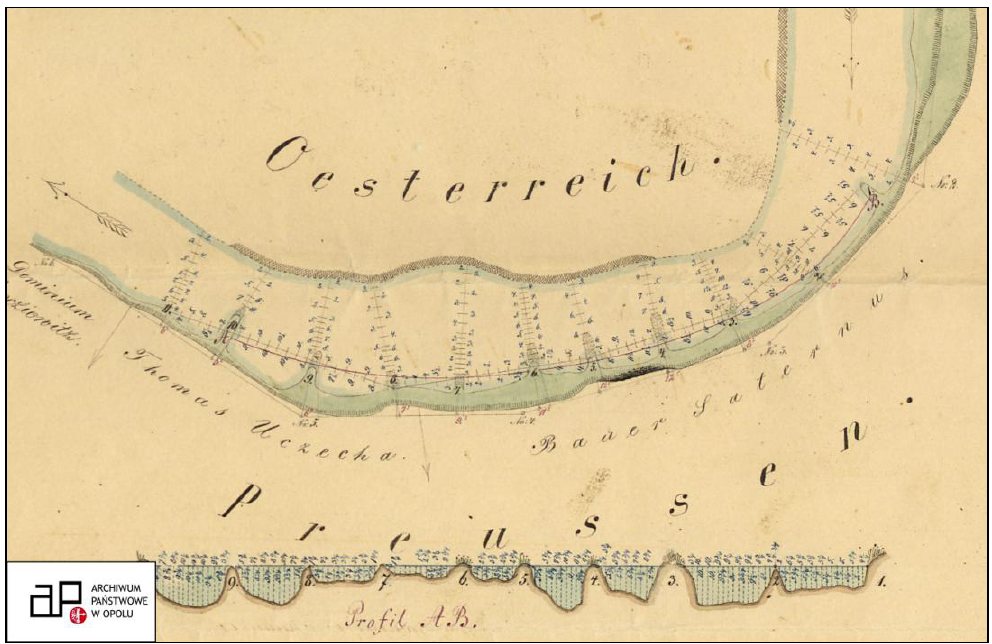
Fig. 3. Hydraulic structures in the River Vistula channel around Czarnuchowice – arrangement and location according to C. Becker (after Situations…, approx. 1840, original scale: ca.